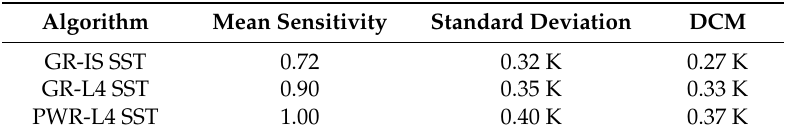
Table 3. Statistics of sensitivities and deviations of ABI SST from CMC SST corresponding to the images in Figures 6 and 7.